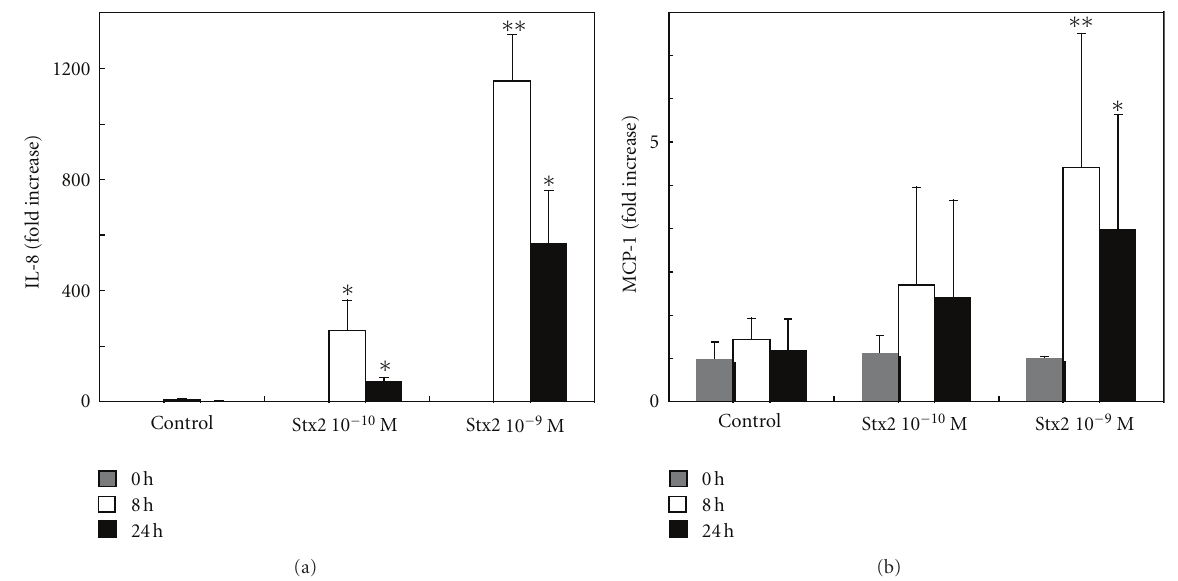
Figure 3: Expression of chemokine mRNA in HASTs upon stimulation with Stx2. The expressions of IL-8 (a) and MCP-1 (b) mRNA was examined by real-time quantitative PCR using HASTs treated with 10 − 10 to 10 − 9 mol/L Stx2 for 8 or 24 h. The levels of induction of IL- 8 and MCP-1 mRNA were calculated relative to the control cultures. Data are expressed as fold increases of mRNA (mean ± SD from five independent experiments). Comparisons were made between the levels of IL-8 and MCP-1 mRNA elicited by Stx2 and those of the untreated controls. ∗ P < 0 . 05 and ∗∗ P < 0 . 01.